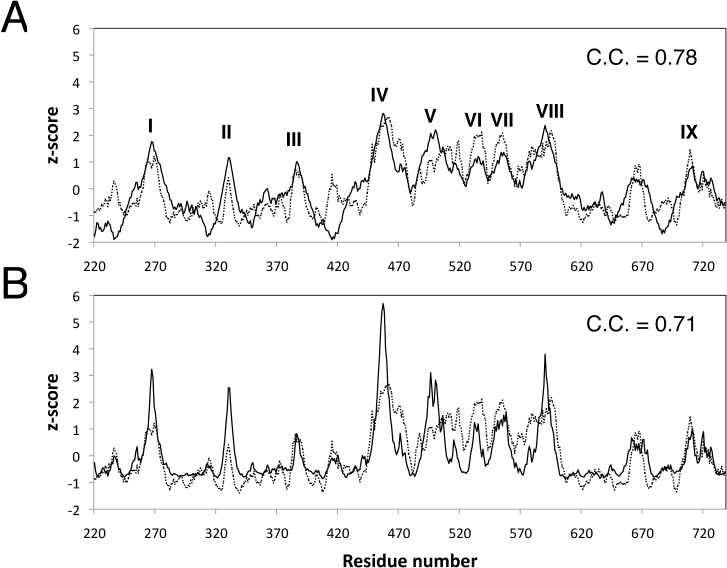
Comparison of the profiles of the viral protein of AAV8 capsid.(A) The c-distance profile (solid line) compared with the sequence conservation profile (dotted line); The variable loop regions I-IX are also labeled. (B) The WCN profile (solid line) compared with the sequence conservation profile. The correlation coefficients are shown.